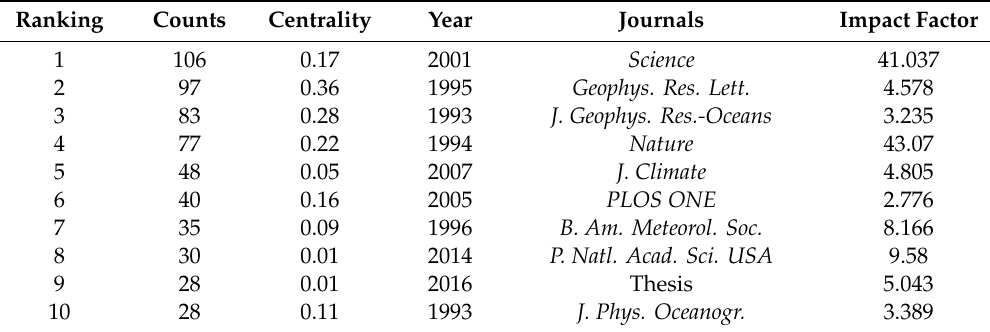
Figure 6. Journals’ co-citation network map. Table 4. Top 10 most cited journals of big ocean data